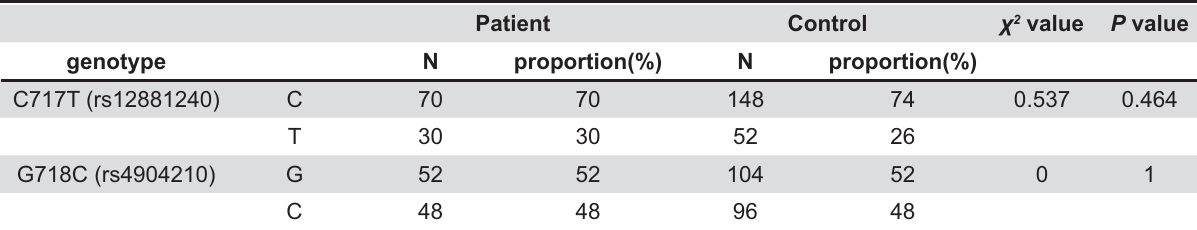
Table 1- Difference analysis of genotype (The differences of two constituent ratio analysis, conducting chi-square statistics) Sample size: 150